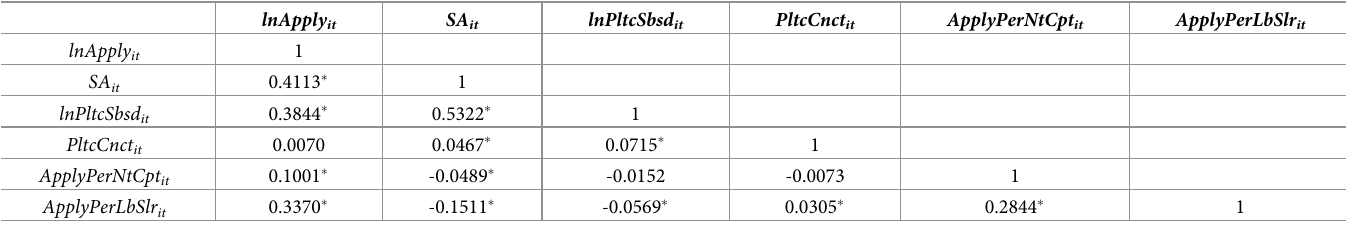
Table 2. Correlation matrix of main